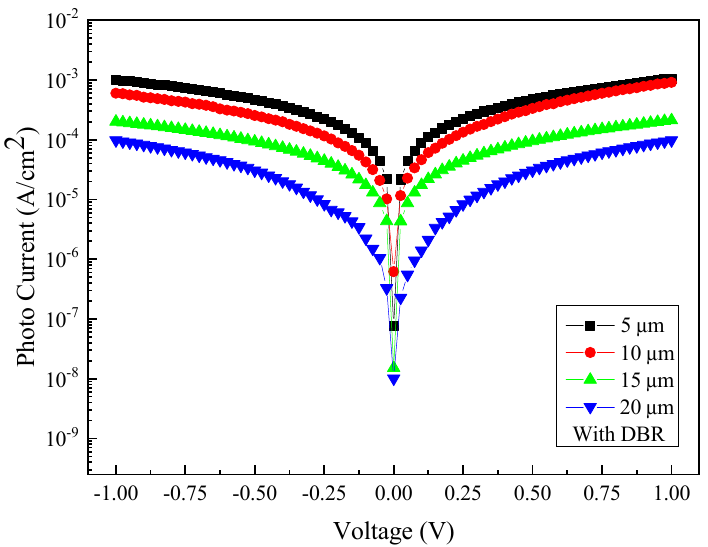
comparison of photocurrent and dark current between different sizes with DBR structures. The data indicate that at least an order of magnitude difference in the current contrasts has been achieved for all the samples under study.